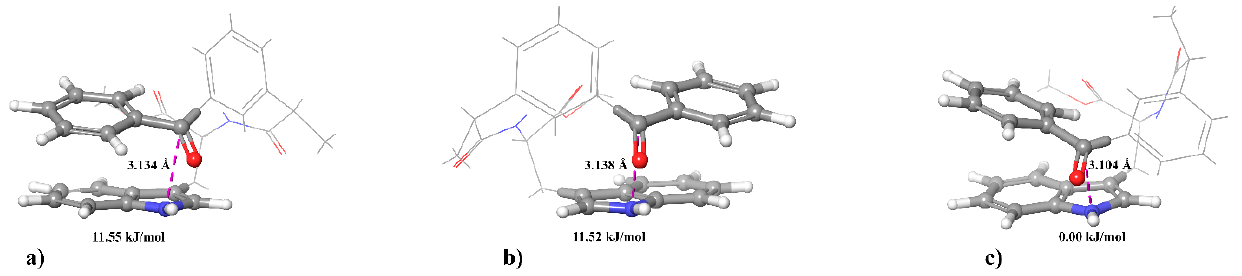
Figure 7. The optimized structures of ( a ) ( R , S )-; ( b ) ( S , R )-; ( c ) ( S , S )-diastereomers of dyad II. Values of Gibbs energy are given relative to ( S , S )-diastereomer [20].